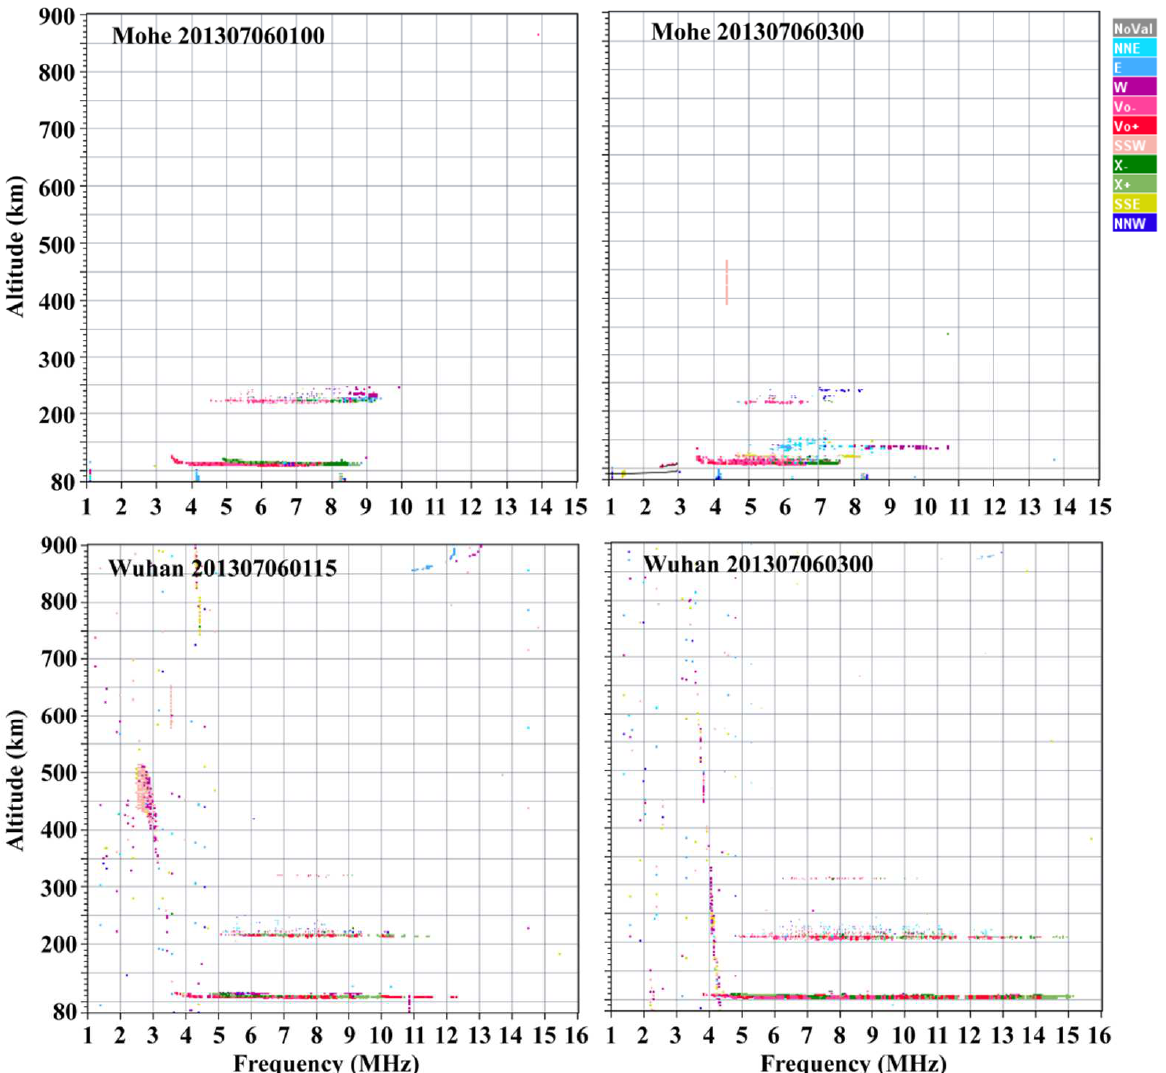
Figure 3. Example of iongrams at Mohe and Wuhan.